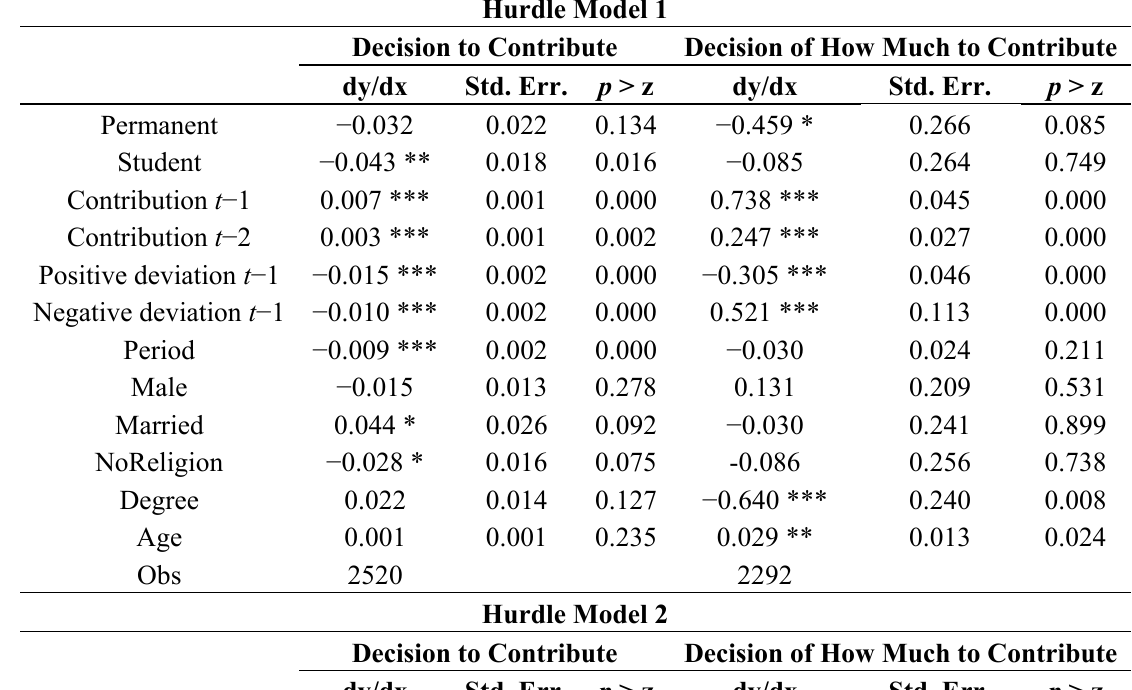
Table 7. Poisson-logit maximum-likelihood hurdle